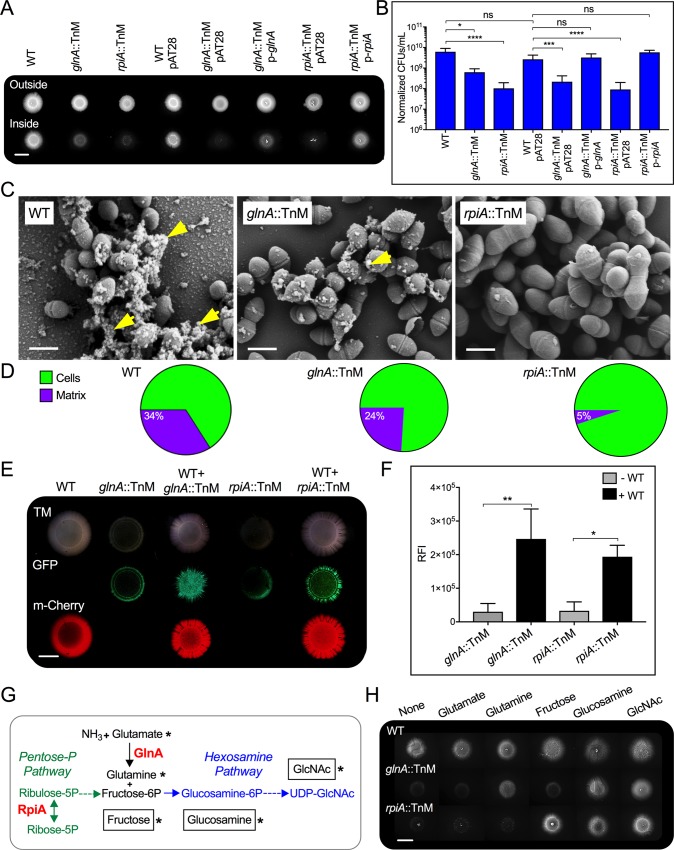
Mutations in glnA and rpiA cause defects in agar penetration that can be restored by extracellular factors or metabolic substrates.(A and B) Semisolid surface penetration by WT E. faecalis MMH594 or the Mariner transposon mutants glnA::TnM and rpiA::TnM, with and without the empty vector pAT28, or in-trans complemented mutants with pAT28 vector harboring their corresponding WT allele (p-glnA and p-rpiA). (A) Macroscopic images of colonies (outside) and invading areas of WT and mutants grown on semisolid MOLP. Scale bar: 6,000 μm. (B) Quantification of cells inside the semisolid surface expressed as CFUs/mL, normalized to their initial absorbance values prior to serial dilutions; (mean±SE; n = 6; *P<0.05; **P<0.01; ***P<0.001; **** P<0.0001 for both the one-way ANOVA and Tukey’s multiple comparison test; nonsignificant, ns). (C) SEM analyses of external bacterial cells. Extracellular matrix is indicated by yellow arrows (scale bar: 400 nm). (D) Fractions of cells and extracellular matrix found on the visible surface of SEM images of non-penetrating strains, quantified through automated image analyses. The pie chart of the non-penetrating WT is based on the same image data used in Fig 1F, outside. (E) Images of colony-prints of WT expressing m-Cherry grown alone or mixed with either glnA::TnM (WT+ glnA::TnM) or rpiA::TnM (WT+ rpiA::TnM) expressing GFP at a 1:2 (WT to mutant) ratio. As control, single cultures of glnA::TnM and rpiA::TnM were spot-inoculated on MOLP. Scale bar: 4,000 μm. (F) Relative fluorescence intensity (RFI) of the colony-prints expressing GFP generated by either mutant alone or co-cultured with WT was measured using Image J. (mean±SE; n = 3; *P<0.05; **P<0.01; one-way ANOVA with Tukey’s multiple comparison test). (G) Metabolic pathways depicting penetration-deficient mutants. RpiA catalyzes the reversible reaction (double-headed arrow) between ribose-5-phosphate (Ribose-5P) and ribulose-5-phosphate (Ribulose-5P). Through the Pentose Phosphate Pathway (Pentose-P-Pathway), RpiA could supply cellular pools of fructose-6-phosphate (Fructose-6P). GlnA synthesizes cellular glutamine from ammonia (NH3) and glutamate. Fructose-6P and glutamine could be used by the cell to form glucosamine-6-phosphate (Glucosamine-6P) that serves as intermediate to generate UDP-N-acetyl glucosamine (UDP-GlcNAc) in the hexosamine biosynthetic pathway (Hexosamine pathway). (H) WT or transposon mutant colonies were assessed for penetration in media without or with exogenous 5–10 mM glutamate, glutamine, fructose, glucosamine and GlcNAc. Scale bar: 6,000 μm. Substrates supplied (asterisk) for metabolic complementation assays (G).